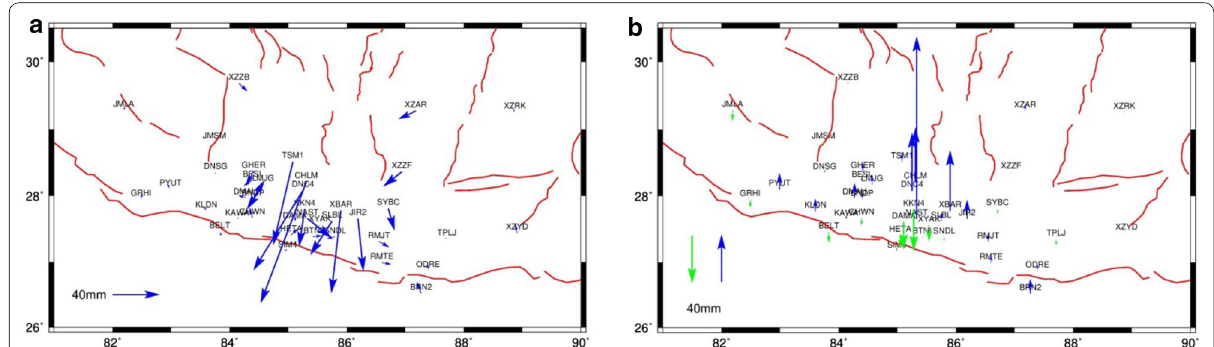
Fig. 2 The cumulative horizontal ( a ) and vertical ( b ) postseismic displacements exacted from GPS displacement time series. The red lines represent active